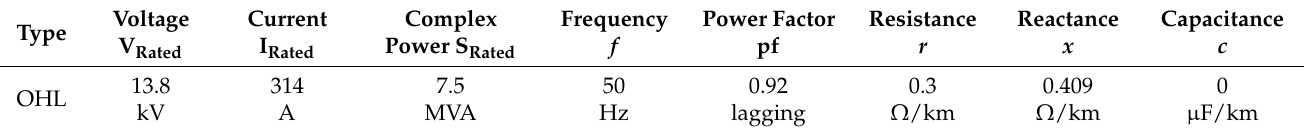
Table 1. Parameters and rated values of the studied Overhead Lines (OHL) [19].